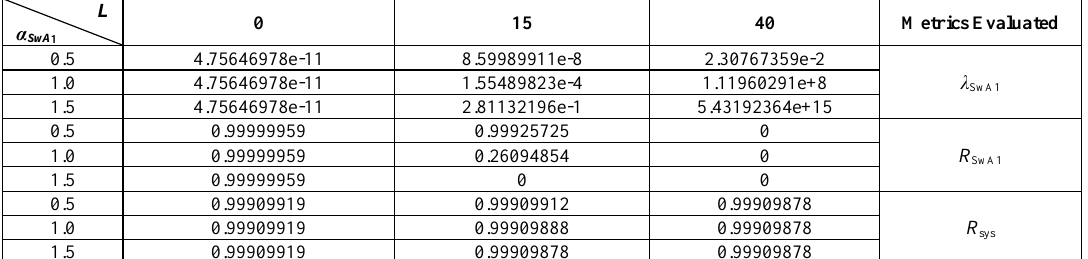
Table 3. Switch failure rate ( λ SwA1 ) and reliability ( R SwA1 ), and SAN reliability ( R sys ) at t= 8640h.